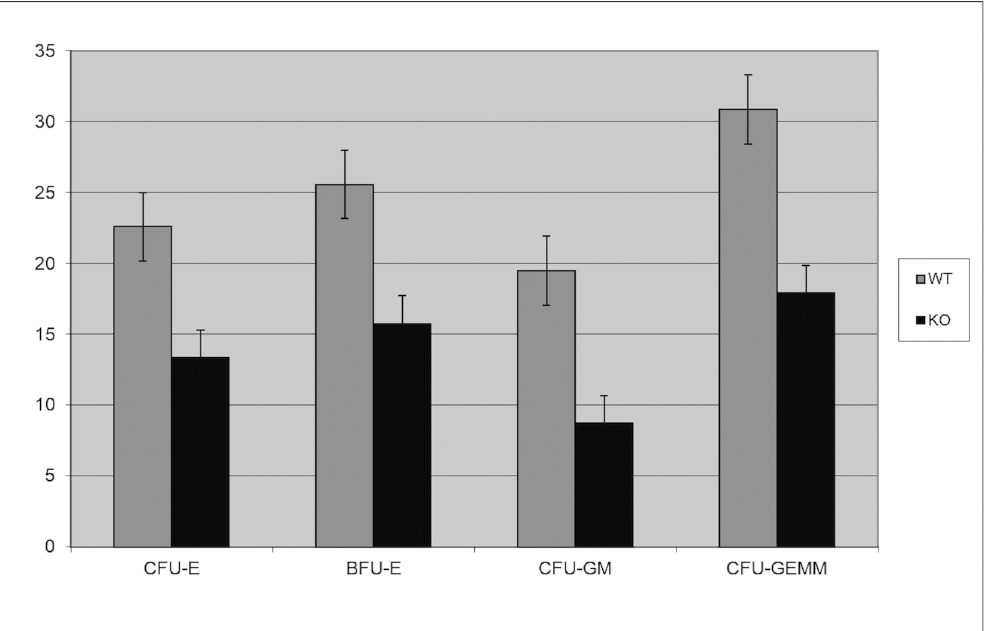
Fig 6. Colony forming assay on 10 months old miR29ab1 knockout bone marrows (n = 8; 4 ko + 4 wt; p = 0.006).